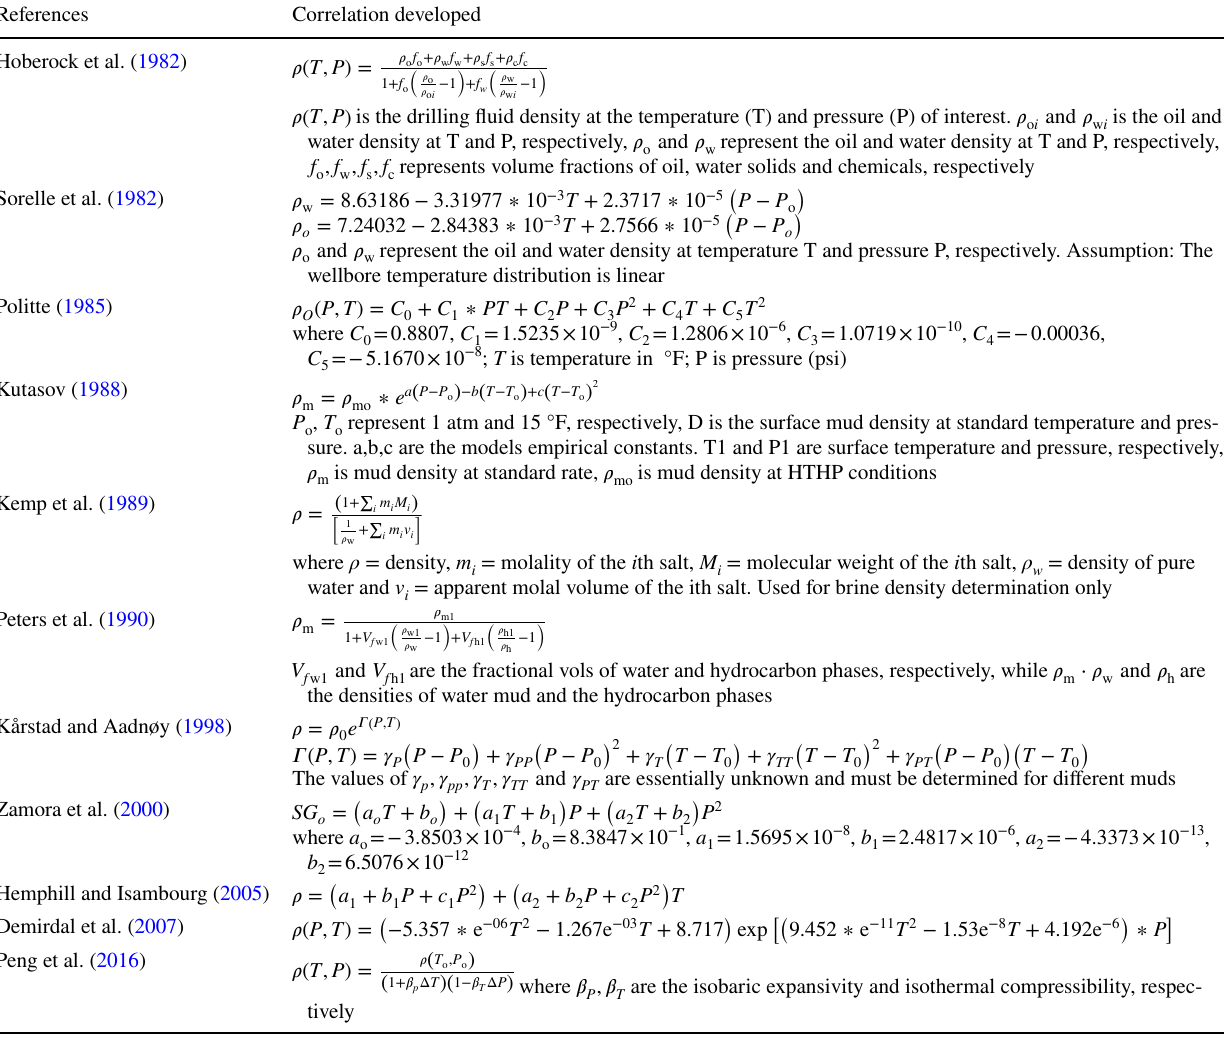
Table 1 Compositional and empirical models for predicting downhole mud density Correlation